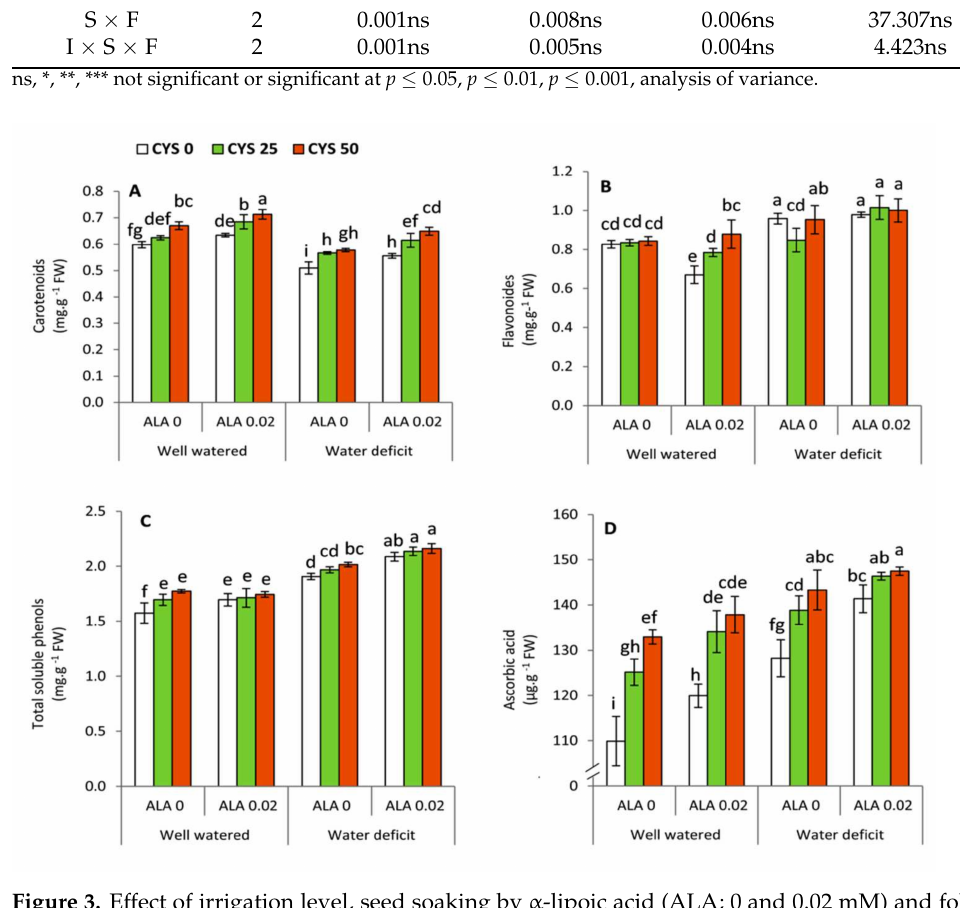
Figure 3. Effect of irrigation level, seed soaking by α -lipoic acid (ALA; 0 and 0.02 mM) and foliar application by cysteine (Cys; 0, 25 and 50 ppm) on the concentration of non-enzymatic antioxidants in wheat plants. ( A ) Carotenoids, ( B ) Flavonoids, ( C ) Total soluble phenols, ( D ) Ascorbic acid. For each parameter, the mean values ± SD followed by a different letter are significantly different according to Tukey’s range test ( p ≤